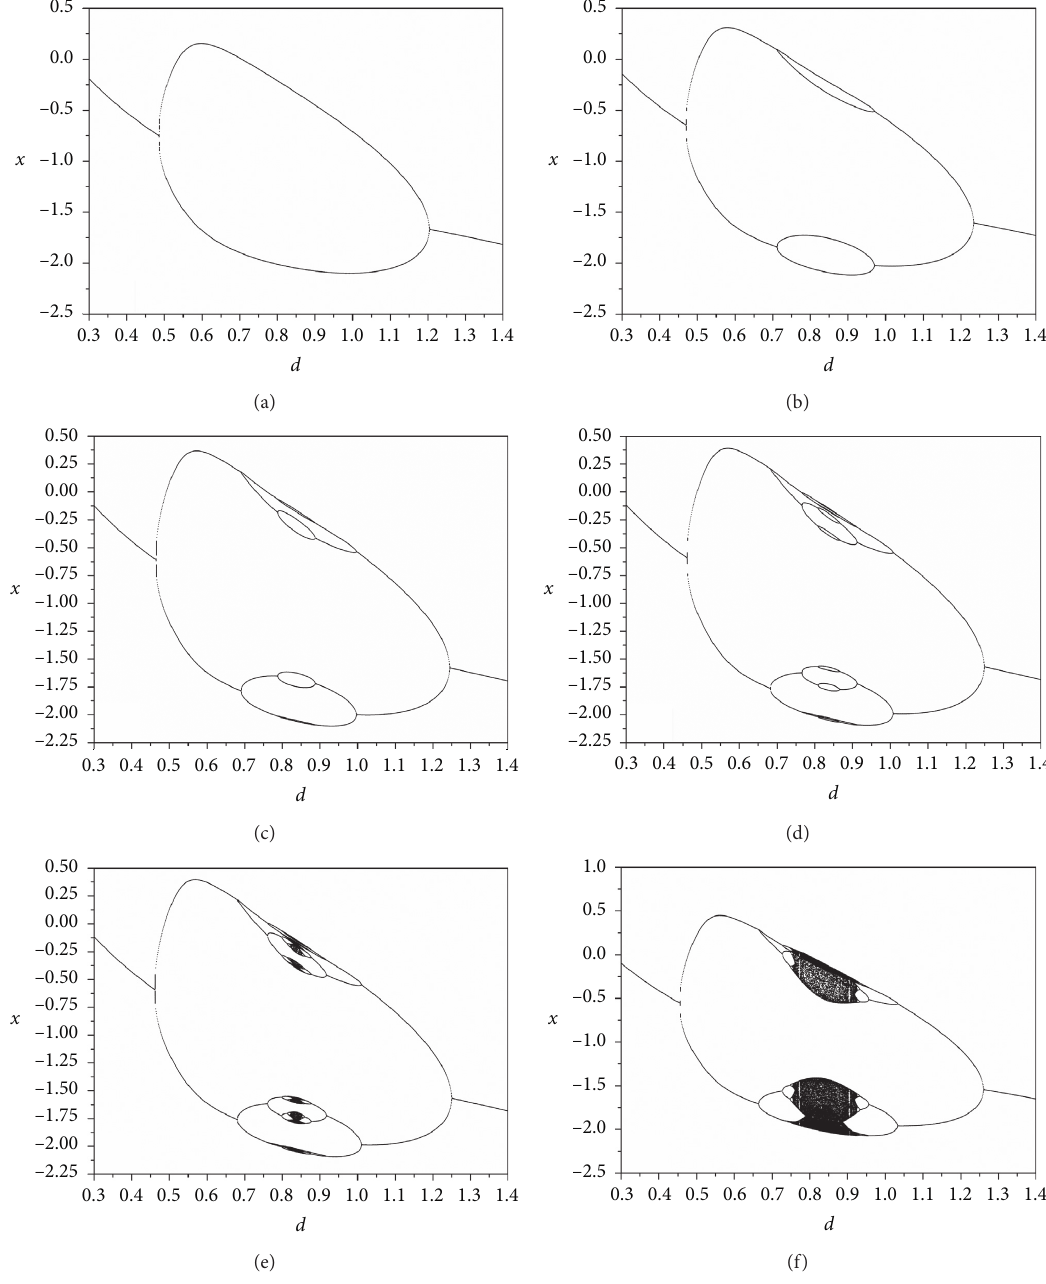
Figure 4: Bifurcation diagrams of x versus d for (a) c � 1.1, (b) c � 1.15, (c) c � 1.17, (d) c � 1.178, (e) c � 1.18, and (f) c � 1.2 with a � 1.4 and b �